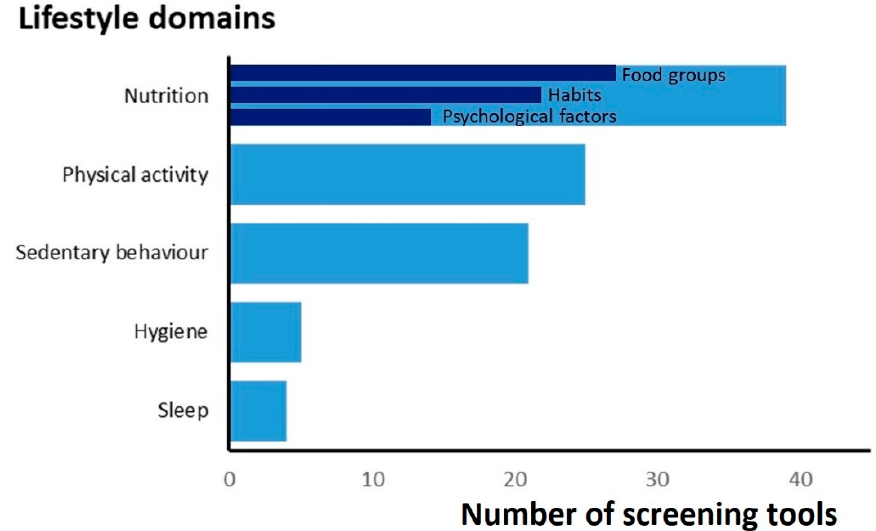
Figure 2. Prevalence of most frequently covered domains. N.B. The total number of covered domains exceeds the number of screening tools ( n = 41) since most tools covered multiple domains.